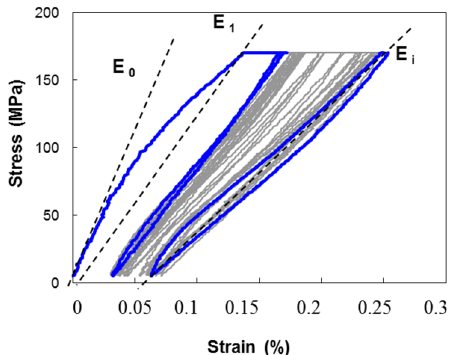
Figure 2. Schematic hysteresis loop and measure of the hysteresis loops modulus, E 0 is the initial Young’s modulus, E i is the secant elastic modulus for the unloading-reloading cycle i .